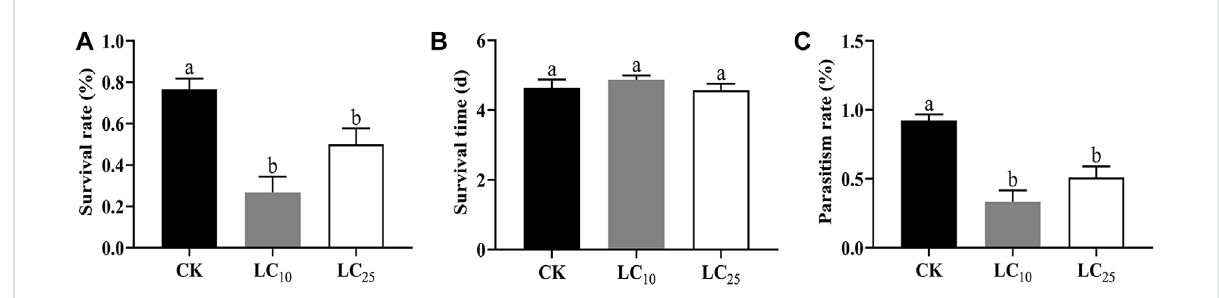
FIGURE 1 Sublethal effects of fi pronil on survival rate, survival time and parasitism rate of Binodoxys communis. Note: (A) survival rate of Binodoxys communis ; (B) survival days; (C) parasitism rate; Columns (Mean ± SE) with the same letters are not signi fi cantly different (Duncan test; p >